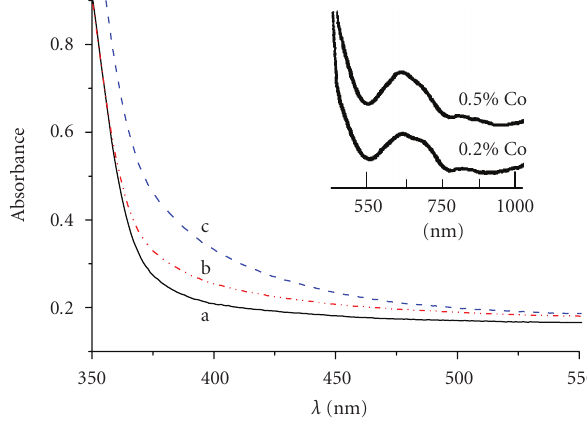
Figure 2: Di ff use reflectance spectra of TiO 2 (a); Co(0.2%)-TiO 2 (b); Co(0.5%)-TiO 2 (c). The inset shows measurements on an ex- panded scale. The final calcination temperature for all samples was 400 ◦